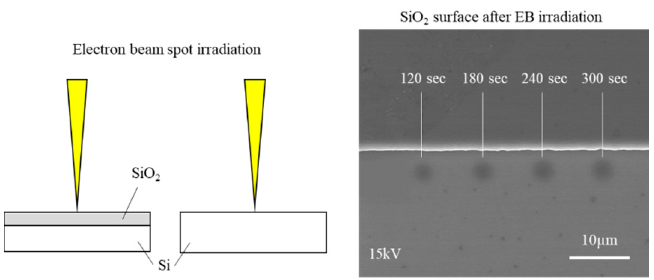
Figure 6. Schematic of EB irradiation along with the SEM image of the SiO 2 surface. The four-circle pattern can be observed on the SiO 2 surface after EB spot irradiation.